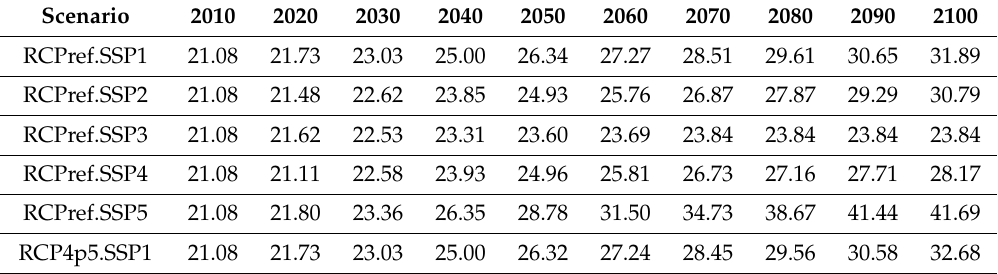
Table A16. Industrial roundwood harvest assortments—Sawlogs (millions of m 3 / year, under bark). Scenario